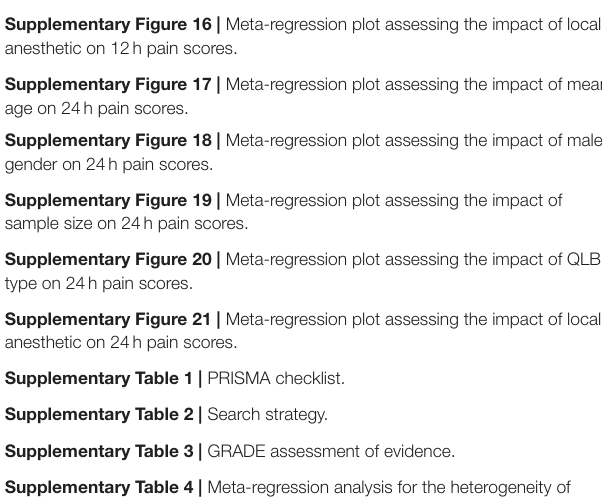
Supplementary Figure 2 | Meta-analysis of 24-h total analgesic consumption between QLB and control groups with exclusion of studies on arthroscopy. Supplementary Figure 3 | Meta-analysis of pain scores between QLB and control groups with the exclusion of retrospective studies. Supplementary Figure 4 | Meta-analysis of pain scores between QLB and control groups with exclusion of the study of Yuan et al. (24h subgroup). Supplementary Figure 5 | Meta-analysis of pain scores between QLB and control groups with exclusion of the study of He et al. ( 21) (48h subgroup). Supplementary Figure 6 | Meta-analysis of pain scores between QLB and control groups with exclusion of the study of He et al. ( 30) (48h subgroup). Supplementary Figure 7 | Meta-regression plot assessing the impact of mean age on 24-h total analgesic consumption. Supplementary Figure 8 | Meta-regression plot assessing the impact of male gender on 24-h total analgesic consumption.